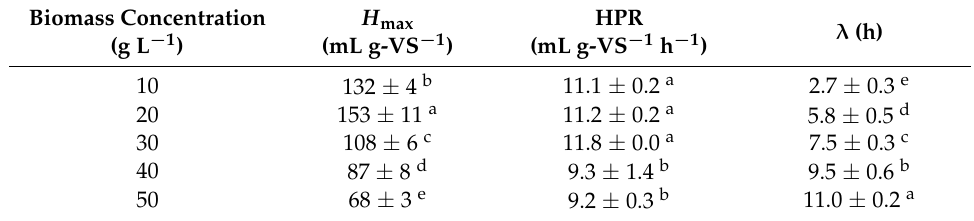
Table 1. Kinetic parameters estimated using the modified Gompertz model for hydrogen production from Chlorella sp. biomass at various biomass concentrations.